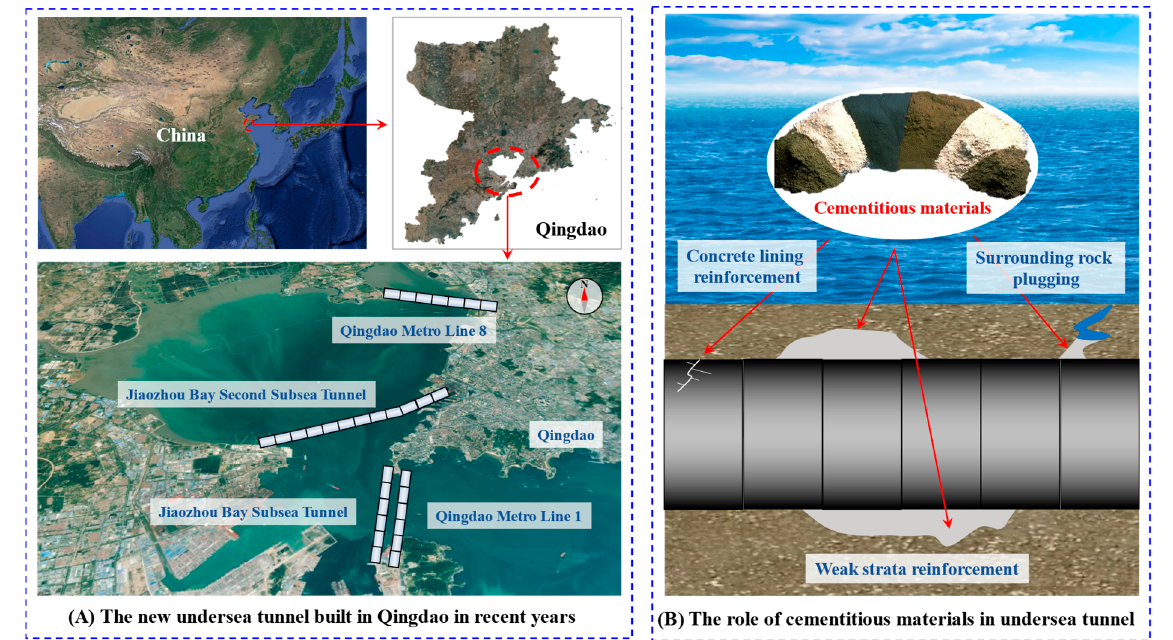
Figure 1. The role of cement-based cementitious materials in growing marine engineering.